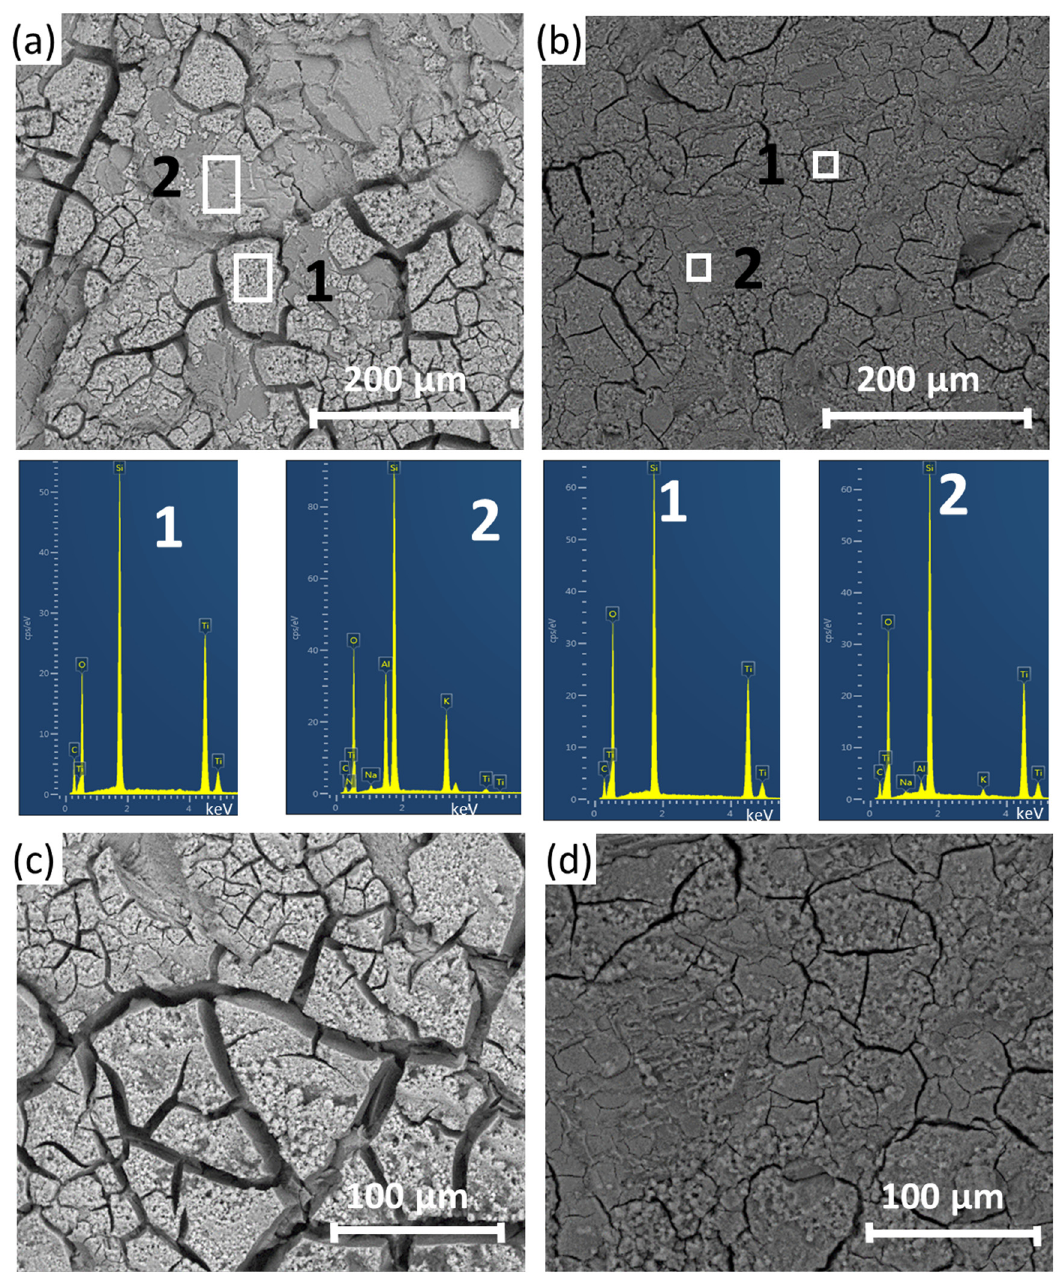
Figure 7. SEM micrographs of the surfaces treated the consolidant products and 3 wt % of TiO 2 nanoparticles concentration. ( a , c ) Estel 1000. ( b , d ) Nano Estel.